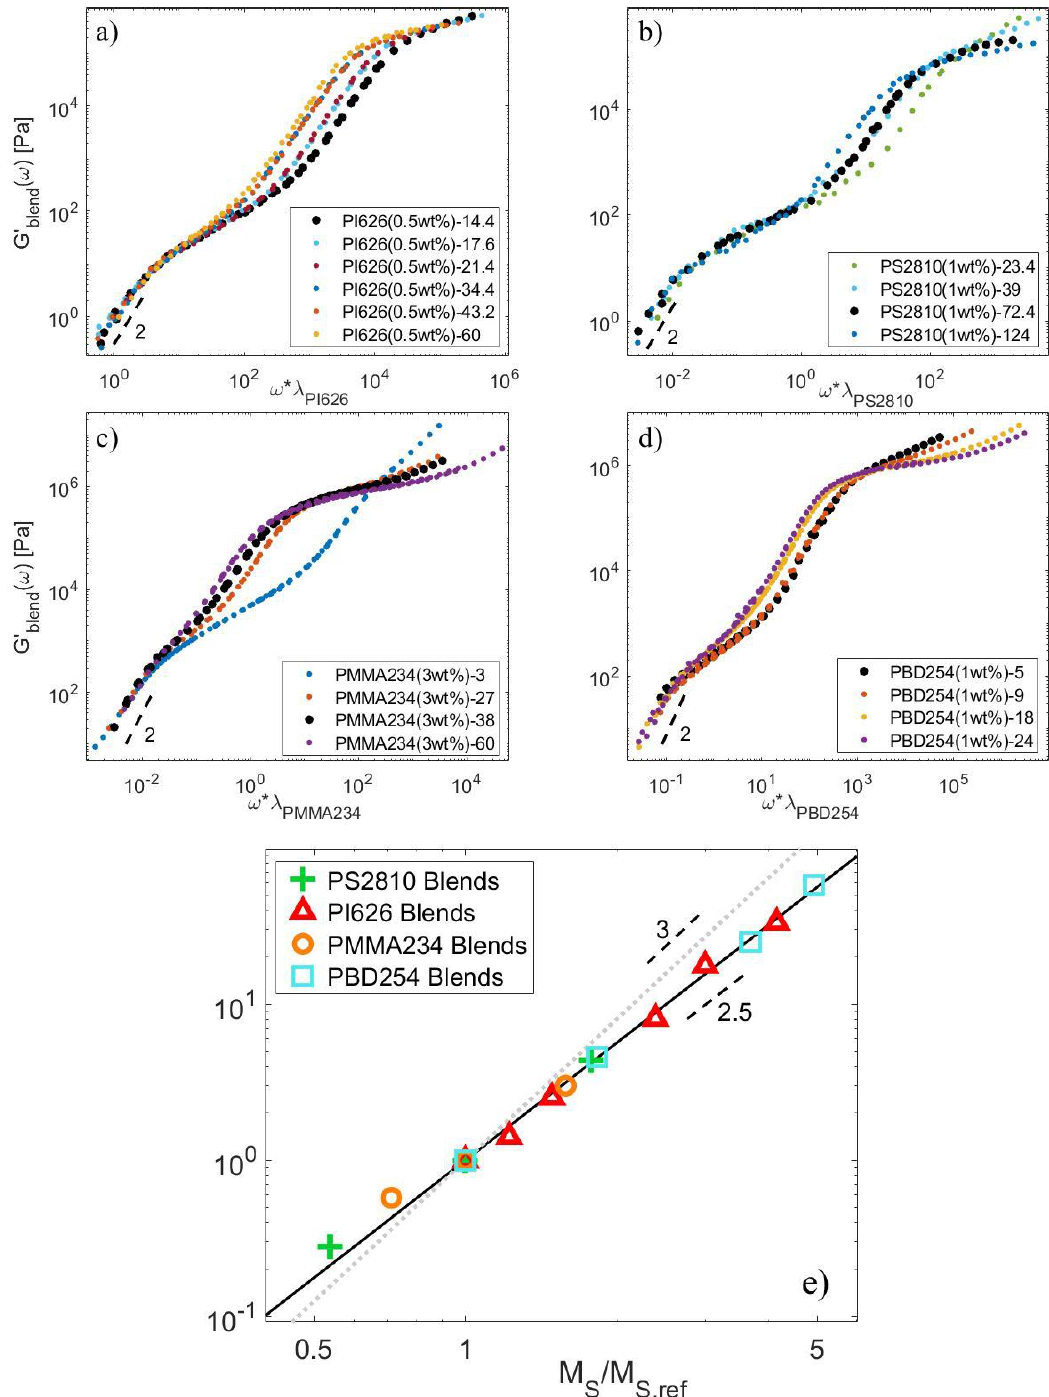
Figure 7. Storage moduli of ( a ) PI626-Matrix blends shifted by a factor λ PI 626 to fit on the terminal regime of PI626 (0.5 wt%)-14.4, ( b ) PS2810-Matrix blends shifted by a factor λ PS 2810 to fit on the terminal regime of PS2810 (1 wt%)-72.4, ( c ) PMMA234-Matrix blends shifted by a factor λ PMMA 234 to fit on the terminal regime of PMMA234 (3 wt%)-38, ( d ) PBD254-Matrix blends shifted by a factor λ PBD 254 to fit on the terminal regime of PBD254 (1 wt%)-5, ( e ) Shift factors λ for each series of blends plotted against M S / M S , ref (symbols). The continuous black line corresponds to , while the M S , ref (cid:16) (cid:17) 3 M S dotted grey line corresponds to . The size of the symbols represents the uncertainty range in M S , ref the value of λ obtained